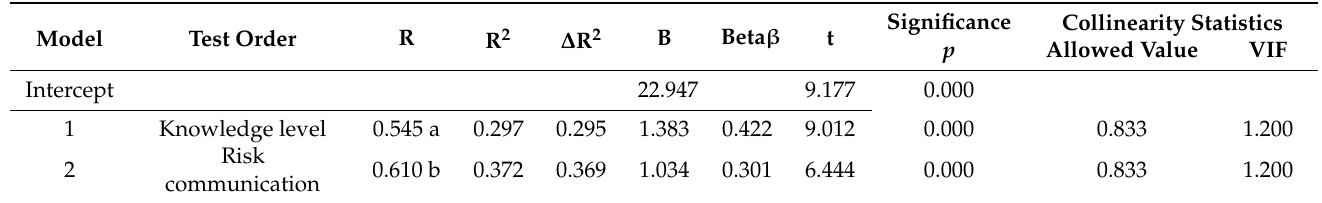
Table 5. Summary of coefficients of regression analysis model for multiple influence factors (stepwise analysis method).